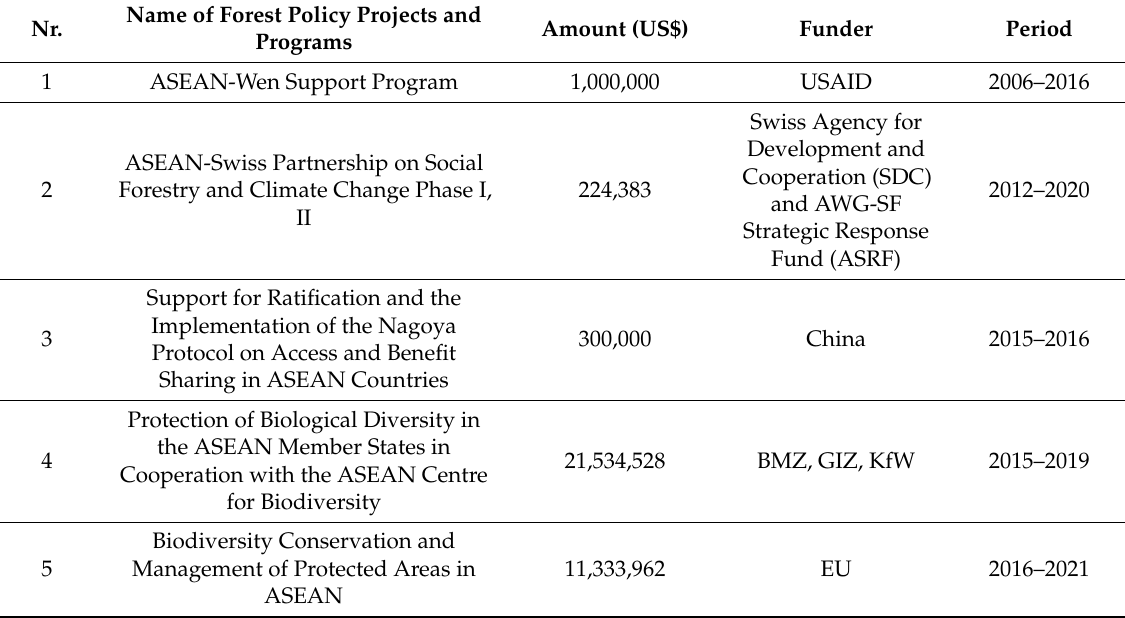
Table A1. The Number of Projects under Current ASEAN Forest